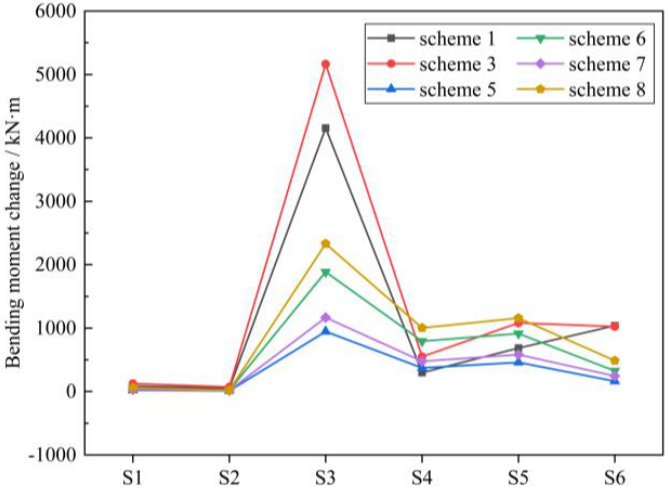
Figure 8. Change in the arch rib bending moment.